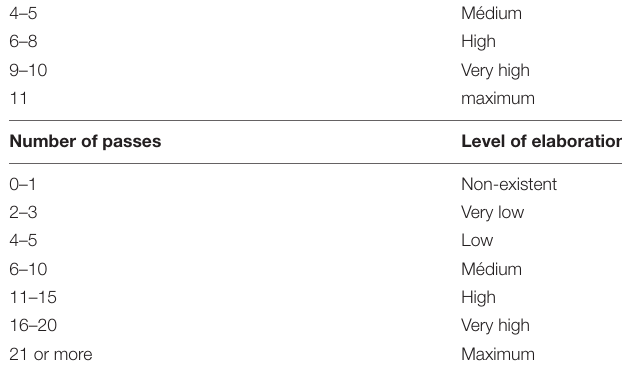
FIGURE 2 | Division into sectors to assess width. Source: Maneiro et al. (2020), adapted from Garganta (1997).